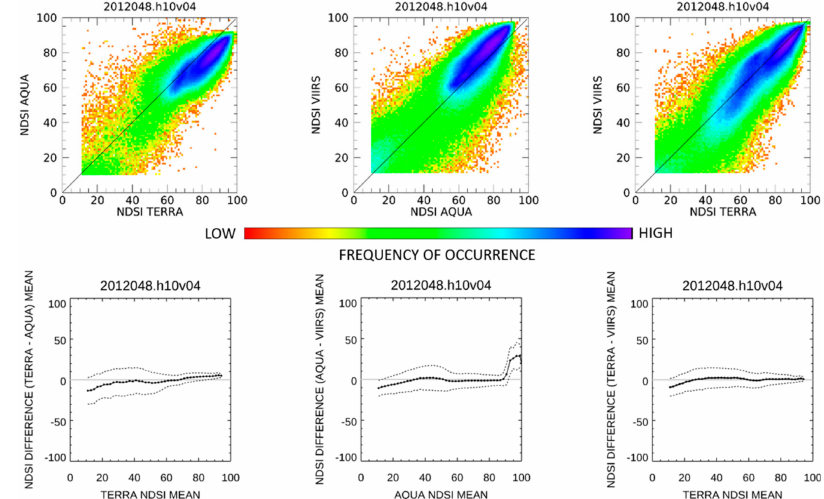
Figure 11. Cross-comparisons of 17 February 2012 for tile h10v04. Cross comparisons MOD10A1 to MYD10A1 ( left ), MYD10A1 to VNP10A1 ( center ) and MOD10A1 to VNP10A1 ( right ). 2D histograms of cell-to-cell NDSI_Snow_Cover comparisons in the top row. NDSI_Snow_Cover mean di ff erences in the bottom row; mean is solid line and standard deviation is dashed